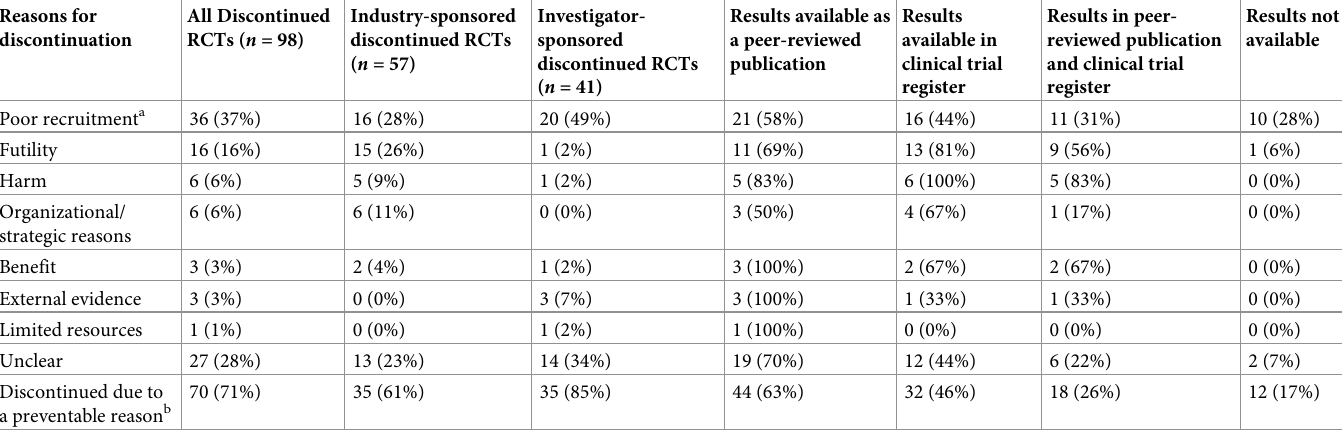
Table 3. Reasons for trial discontinuation and proportion of results